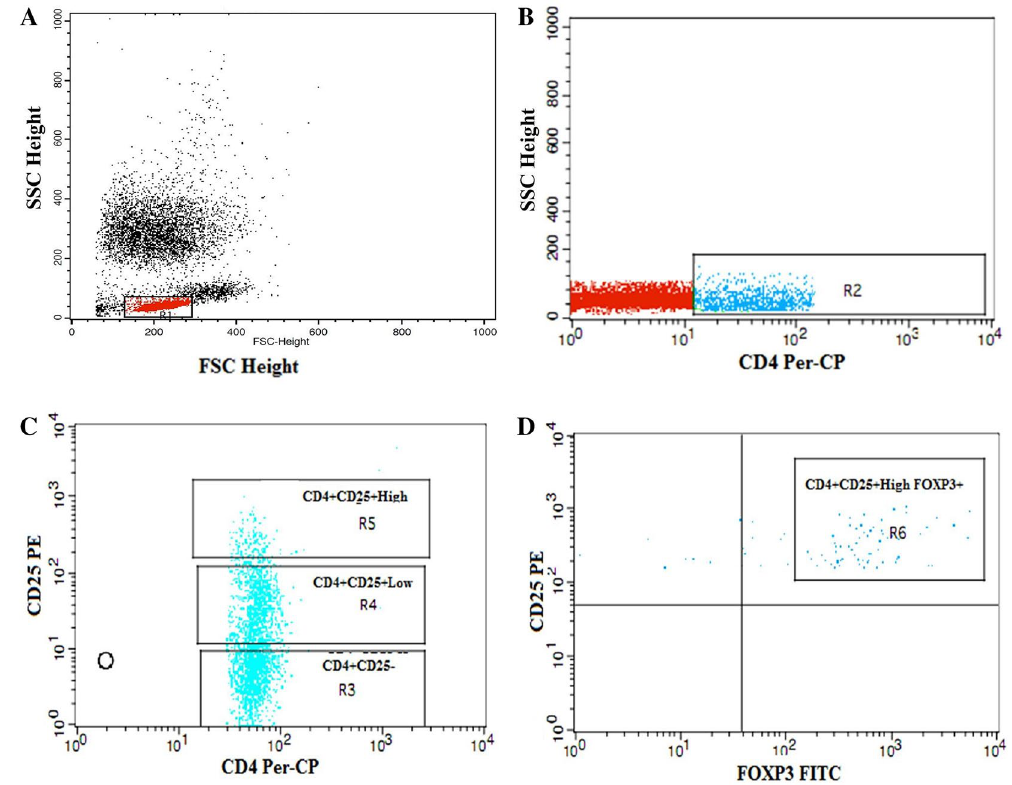
Figure 1. Flow cytometric detection of regulatory T cells. ( A ) The lymphocyte population was defined on forward, and side scatter histogram (R1). ( B ) The expression of CD4 on the lymphocytes population was detected, then CD4 + cells were gated for further analysis of CD25. ( C ) Three gates were drown to define CD4 + CD25 - cells, CD4 + CD25 +low cells and CD4 + CD25 +high cells. ( D ) The percentage of CD4 + CD25 +high Foxp3 + cells (regulatory T cells) was then